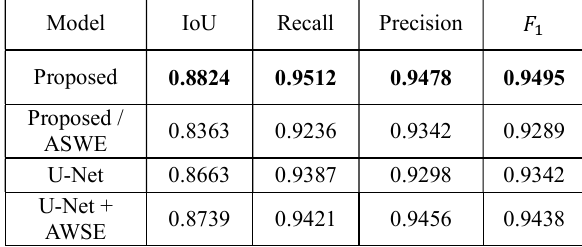
Table 4. Accuracy statistics of ablation experiments of the AWSE module.